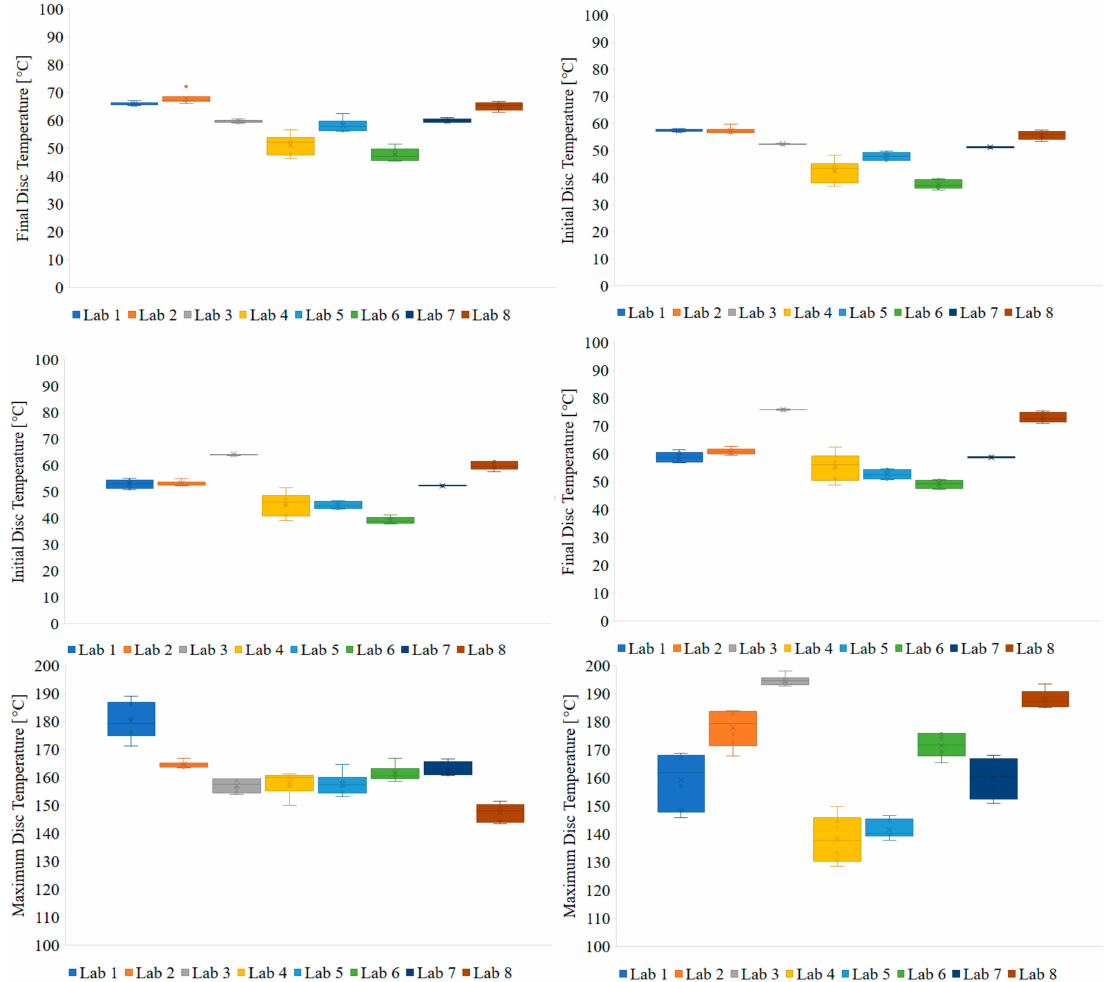
Figure 8. Boxplots for the average disc temperatures—the plots illustrate values for initial (upper panels), final (middle panels), and maximum (bottom panels)